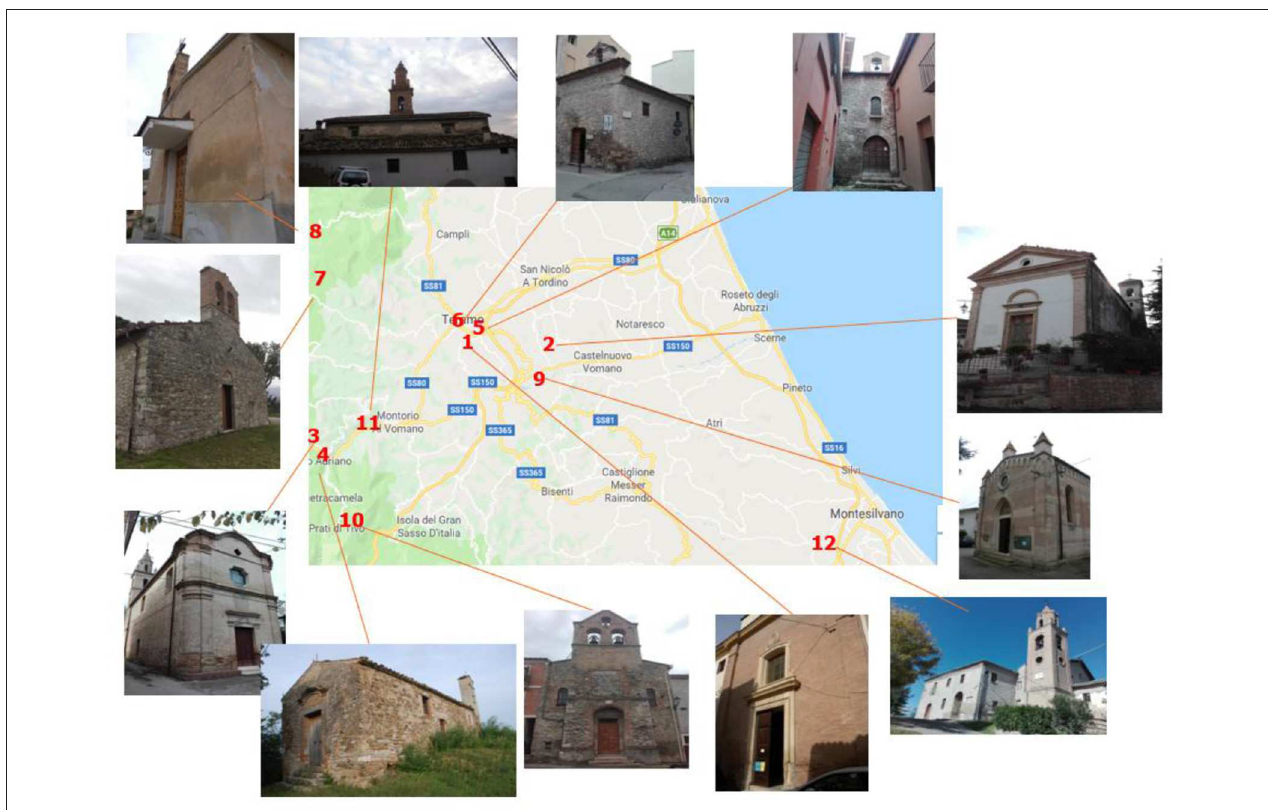
FIGURE 3 | Location of investigated churches in the city of